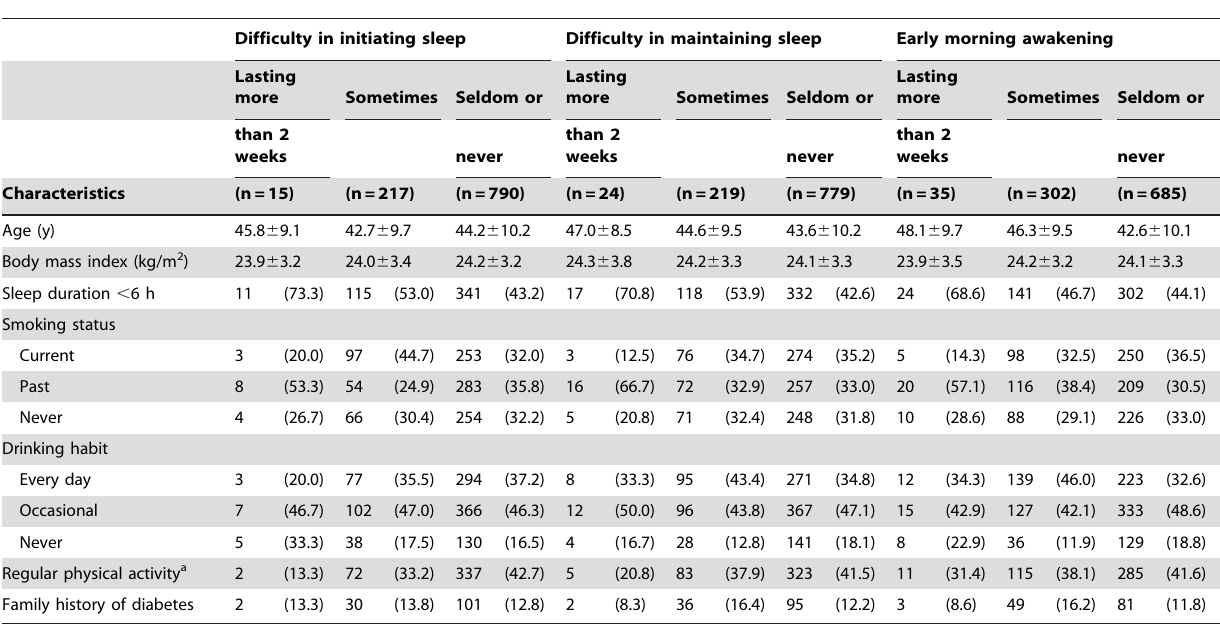
Table 1. Characteristics of participants, by 3 categories of each insomnia symptom (n=1,022).